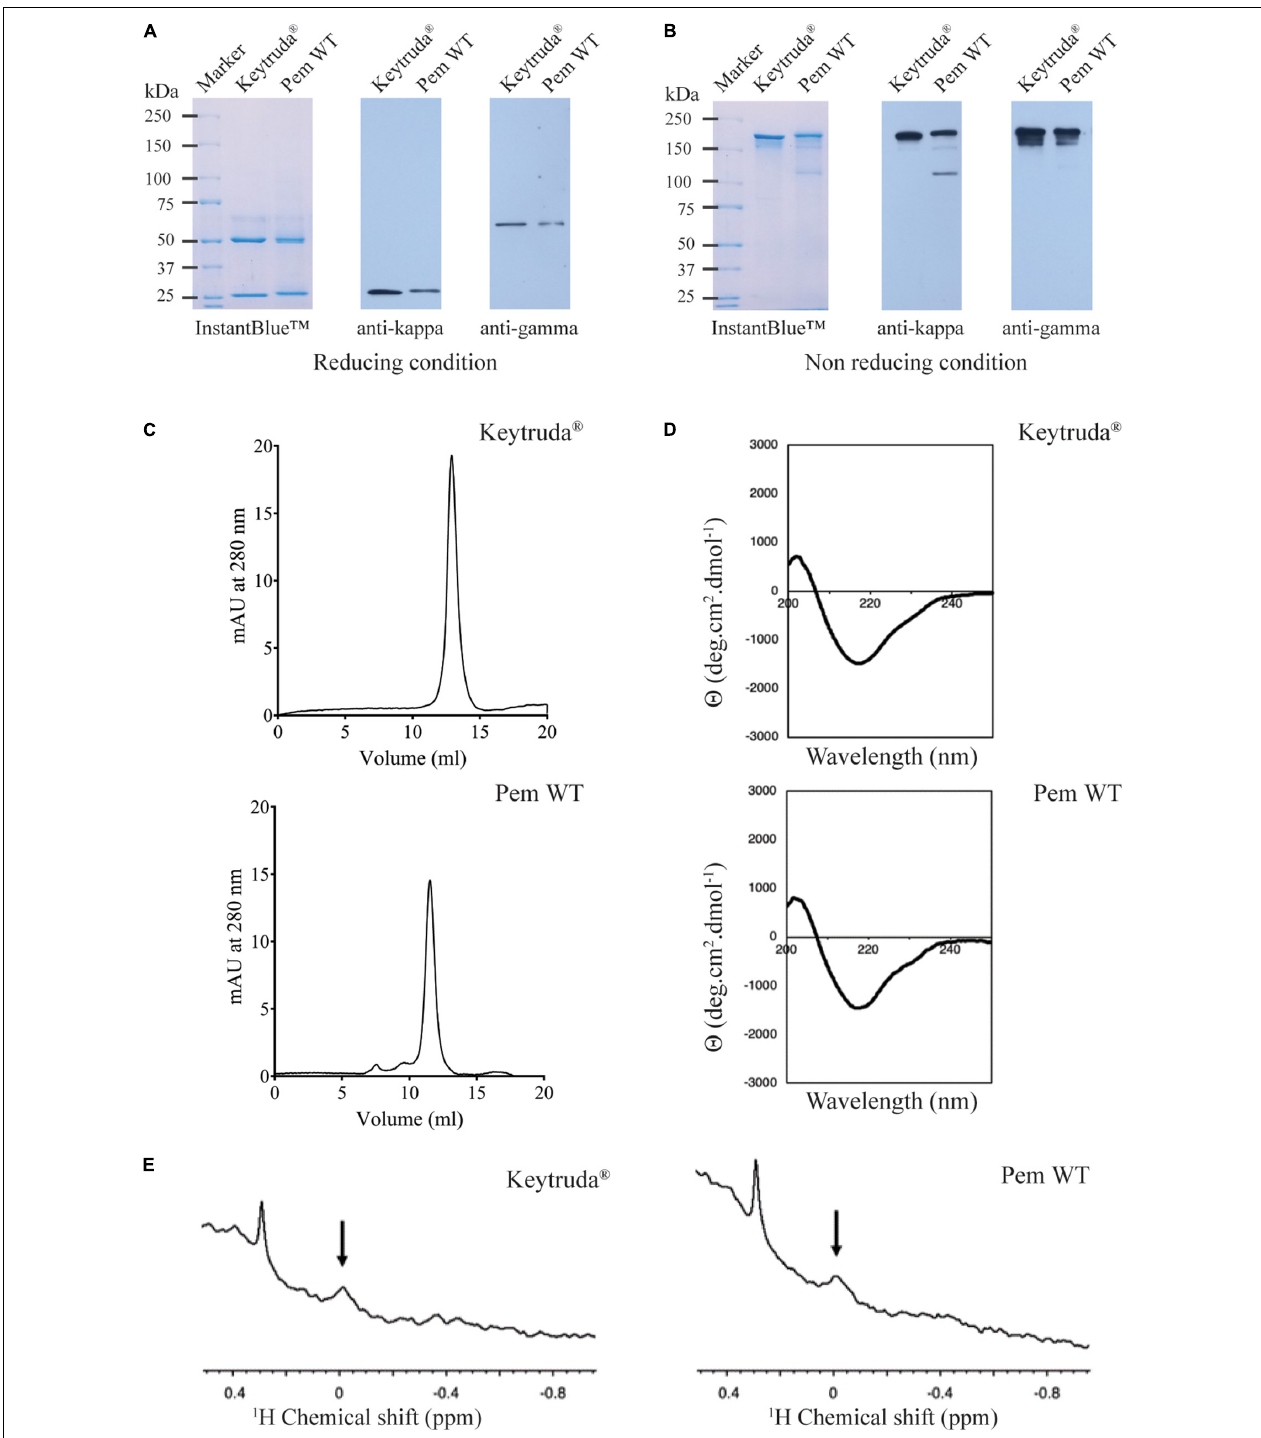
FIGURE 2 | Physicochemical characteristics of purified plant-produced Pembrolizumab. Sodium dodecyl sulfate polyacrylamide gel electrophoresis (SDS-PAGE) (4–15%) and western blot analysis of plant-produced Pembrolizumab (Pem WT) under (A) reducing condition and (B) non-reducing condition. For the SDS-PAGE, proteins were stained with InstantBlue TM staining solution. For the western blot analysis, proteins were probed with either HRP-conjugated anti-human kappa or anti-human gamma and detected with enhanced chemiluminescence (ECL) substrate solution. (C) Chromatogram of Keytruda R (cid:13) (top) and Pem WT (bottom) analyzed by size-exclusion chromatography. (D) Circular dichroism spectrum of Keytruda R (cid:13) (top) and Pem WT (bottom) in PBS at pH 7.4. (E) NMR spectra in methyl region of Keytruda R (cid:13) (left) and Pem WT (right) in PBS buffer at pH 7.4 containing 10% v/v D 2 O at 25 ◦ C.